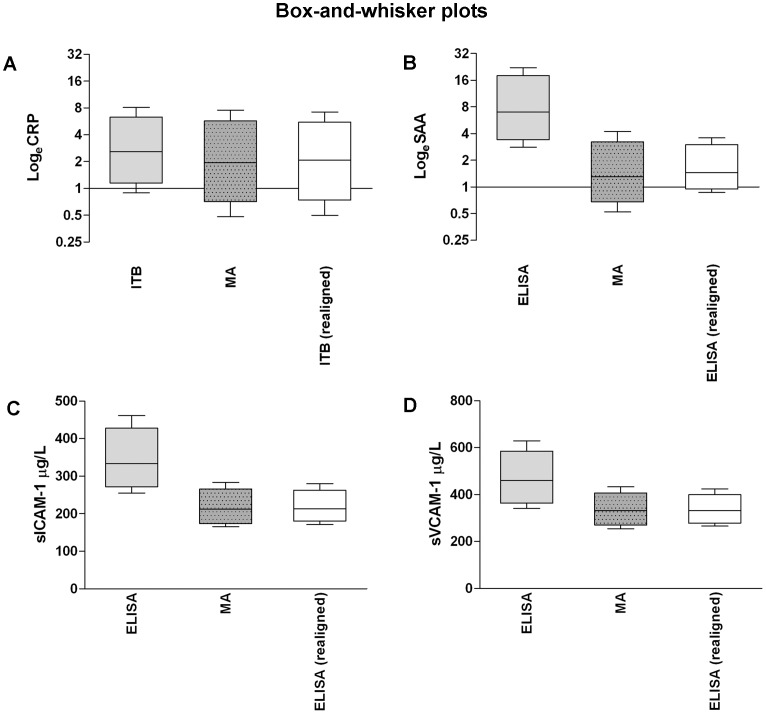
Box-and-whisker plots showing median and interquartile (box) and 10th and 90th centiles (whiskers) for each biomarker, before and after realignment to current (multi-array) concentrations.(A) CRP, C-reactive protein (n = 566); (B) SAA, serum amyloid A (n = 563); (C) sICAM-1, soluble intercellular adhesion molecule 1 (n = 566); and (D) sVCAM-1, soluble vascular cell adhesion molecule 1 (n = 567); ITB, immunoturbidimetry; MA, multi-array.